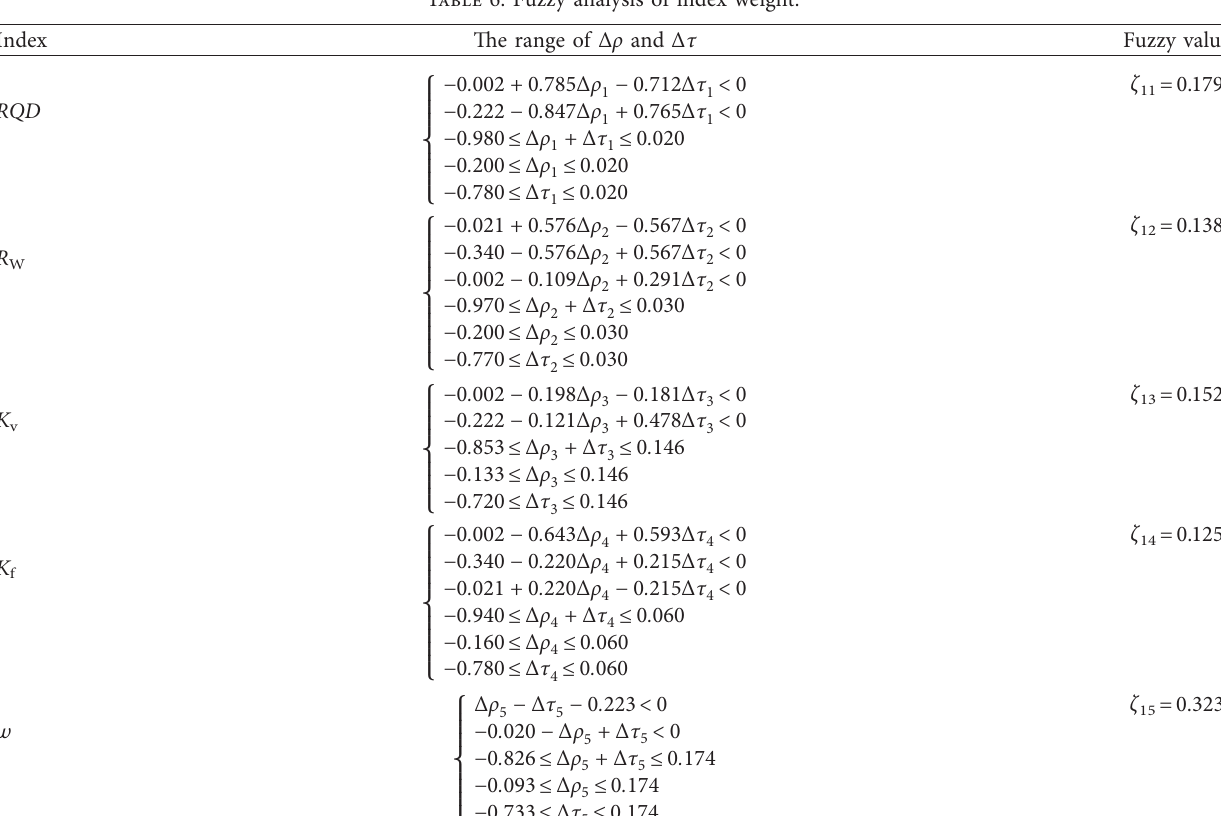
Table 6: Fuzzy analysis of index weight.